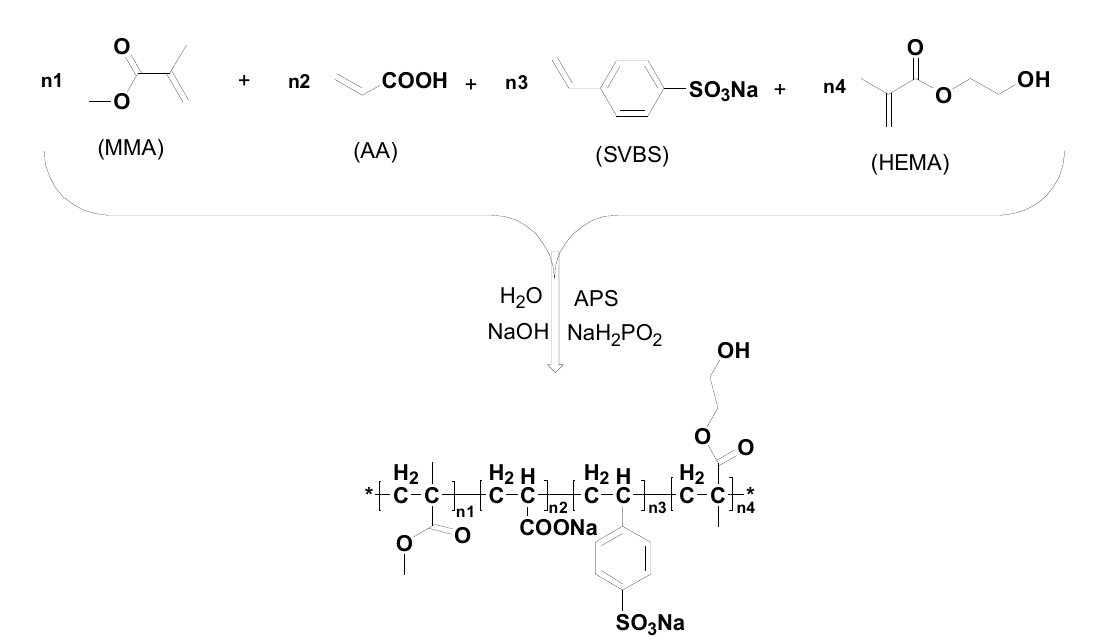
Figure 2. Copolymerization process of dispersant PD0x. Table 1. Synthesis conditions of dispersants PD0x.